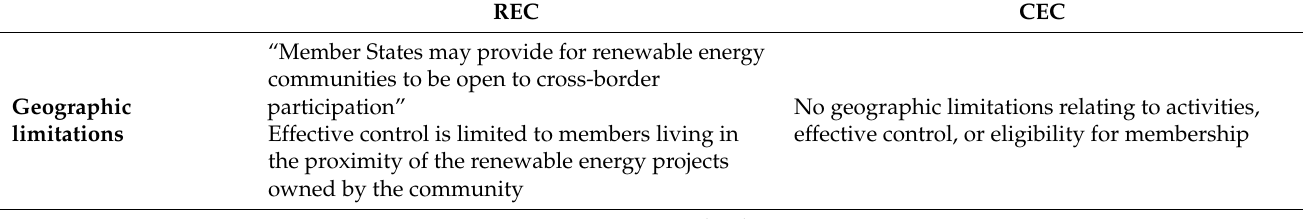
Table 1. Similarities and differences between RECs and CECs